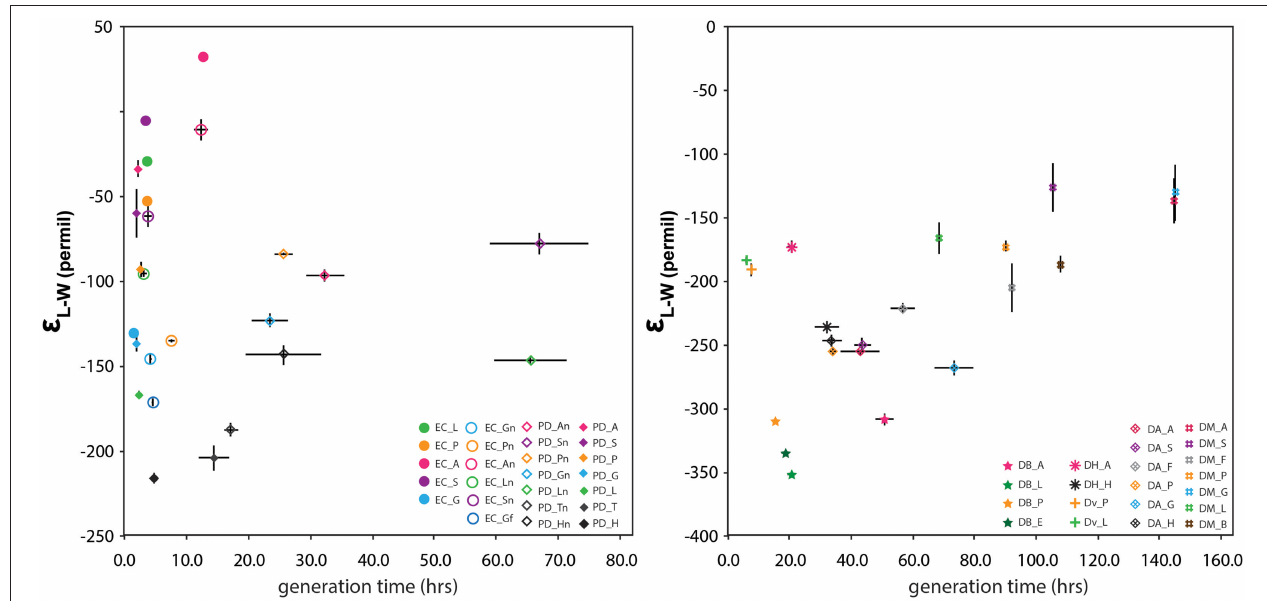
FIGURE 3 | The relationship between generation time (h) and ε L–W for facultative anaerobes (left) and sulfate-reducers (right). Error bars for fractionation reflect replicate measurements whereas those for generation time derive from standard error on growth curve regressions.